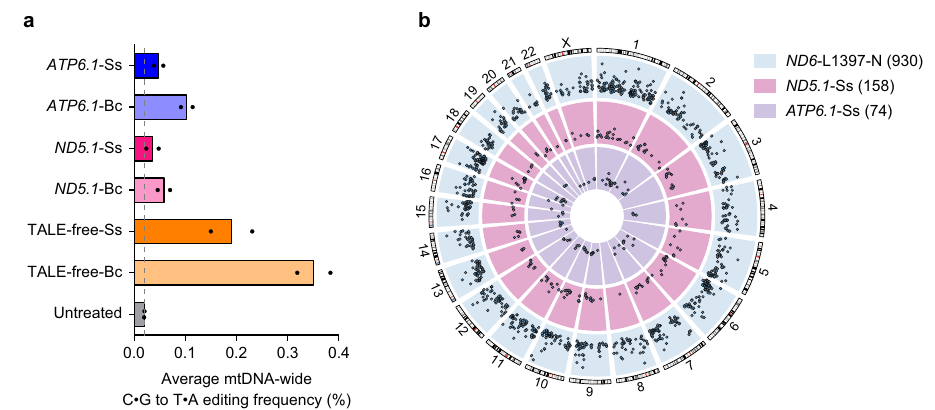
Fig. 4 | Mitochondrial and nuclear genome-wide off-target editing by DdCBE_Ss. a Average percentage of mtDNA-wide C • G to T • A off-target editing in untreated HEK293T cells and HEK293T cells treated with different DdCBEs. The vertical line represents the percentage of mtDNA C • G to T • A editing ef fi ciency in untreated cells. Shown are the mean from n =2 independent experiments.